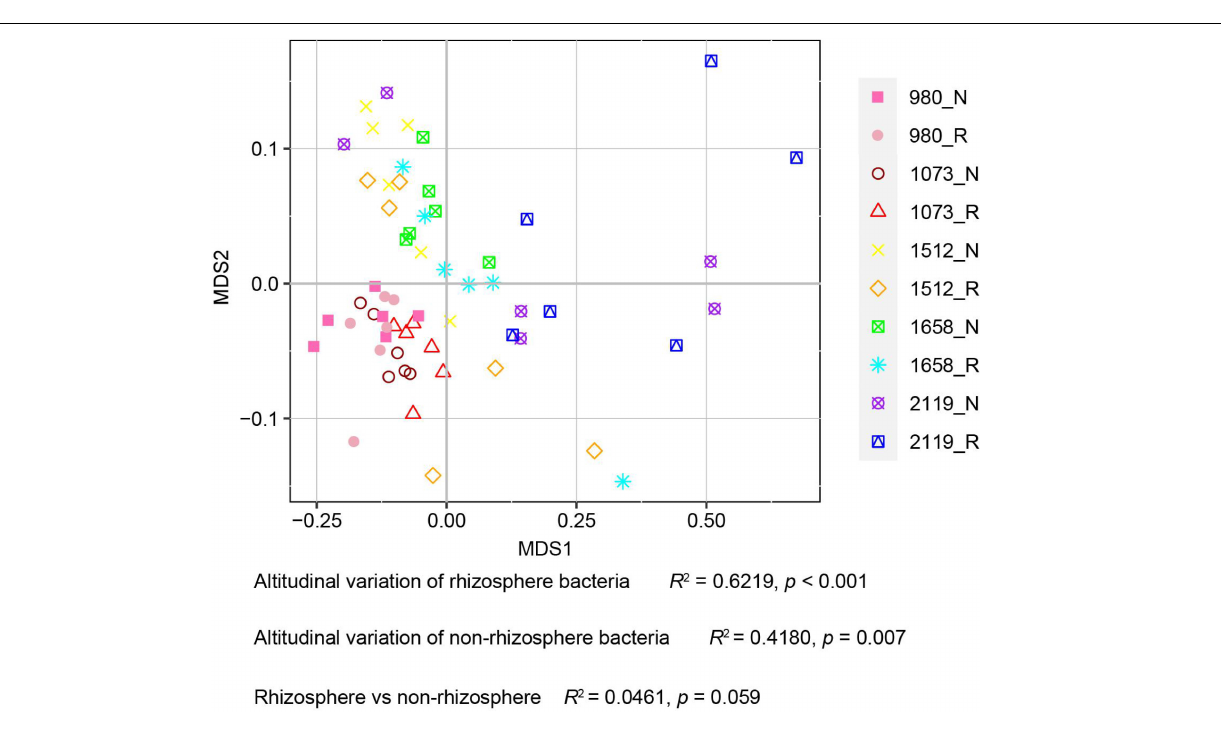
FIGURE 3 | Non-metric multi-dimensional scale analysis (NMDS) analysis for T. sutchuenensis soil beta diversity. The beta diversity is calculated based on the relative abundances of OTUs. Values of R 2 and p were calculated using Permutational MANOVA (Permanova). R and N indicate rhizosphere and bulk soil samples,